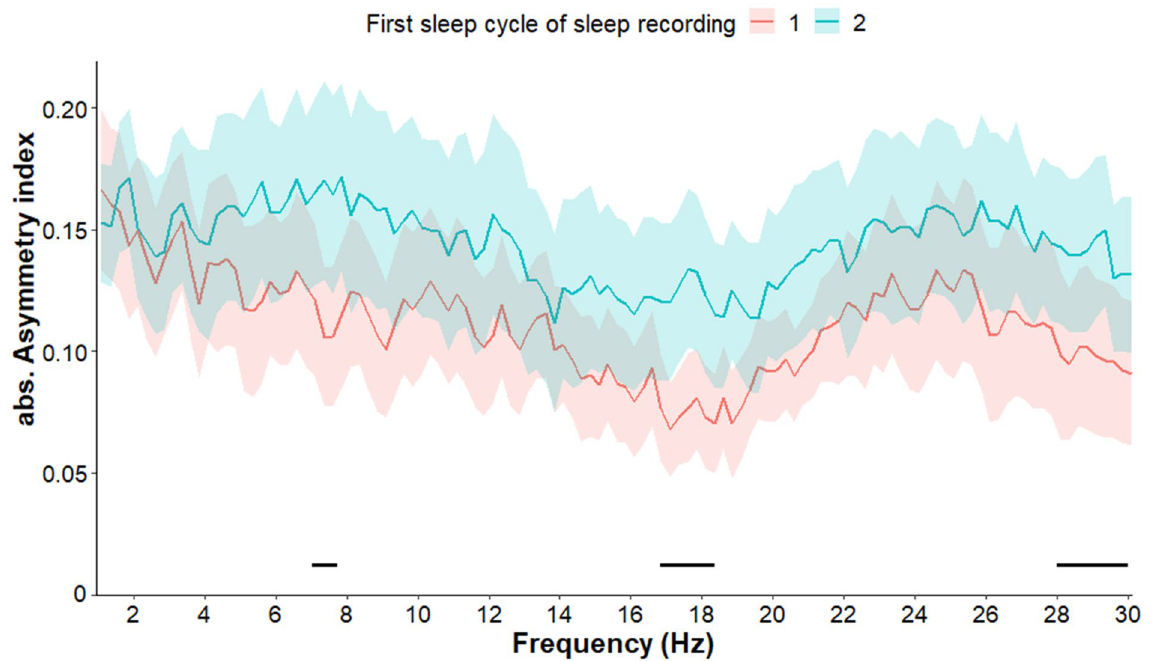
Figure 7. Absolute asymmetry index values (Mean + / − SE) in frequency range 1–30 Hz in the first sleep cycles of sleep recording 1 and 2. In the second sleep cycle greater asymmetry was observed in the frequency ranges of 7–7.75, 16.75–18.25 and 28–30 Hz, compared to the first sleep cycle. Frequency bins below the statistical threshold (all p s < 0.05, fulfilling the criteria of a significant Rüger area) are illustrated by a black horizontal